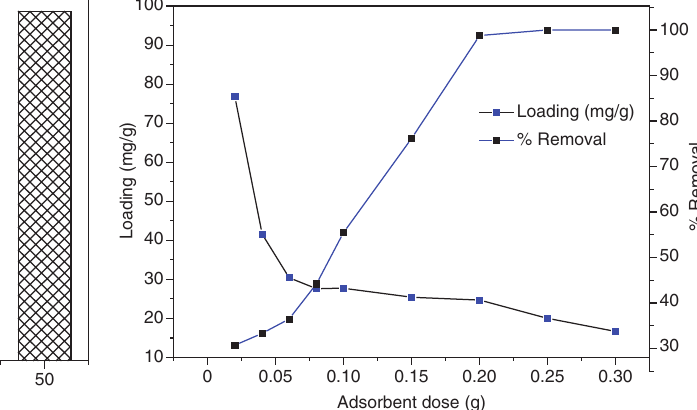
Figure 6 Effect of Fe loading on the adsorption of Cr(VI) (initial con- centration = 100 mg/l, weight = 0.2 g, temperature = 30 ° C, time = 24 h).